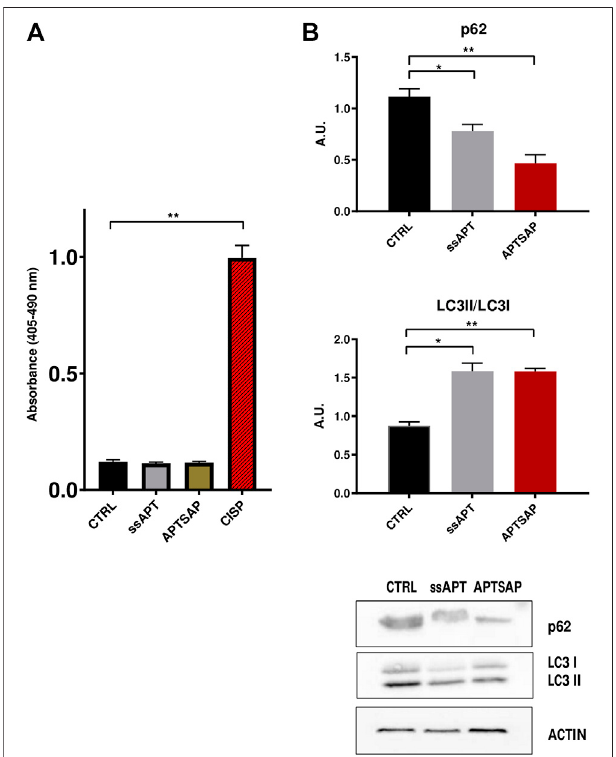
FIGURE 7 | (A) Detection of nucleosome fragmentation in cytoplasmic fractions. Apoptosis was detected using the Cell Death detection ELISA kit. U87MG cells were treated for 96 h with APTSAP and ssAPT complexes. Cisplatin (CISP) treatment of the cells was used as a positive control. (B) p62 and LC3 immunoblotting analysis of U87MG cells after 96 h treatment with ssAPT (25 µM) and APTSAP (20 nM) and relative densitometric analysis. Statistical analysis was performed by the ANOVA test. * p < 0.033 ** p < 0.0021.